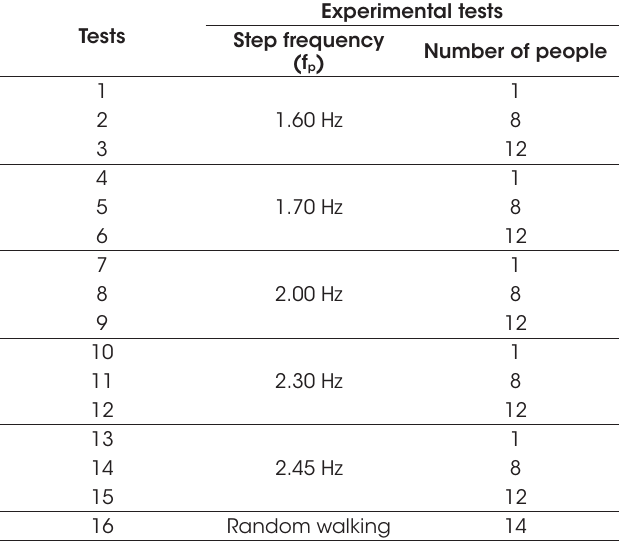
Investigated forced vibration tests: experimental